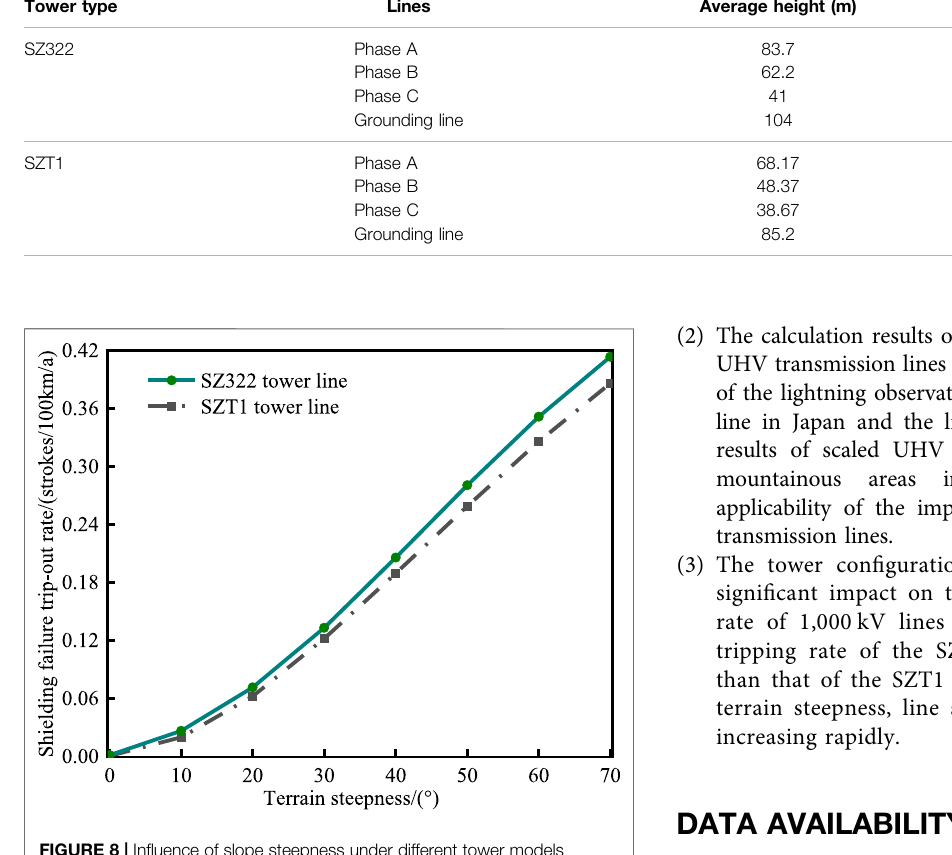
FIGURE 8 | In fl uence of slope steepness under different tower models on shielding failure tripping out rate of 1,000 kV lines in China.